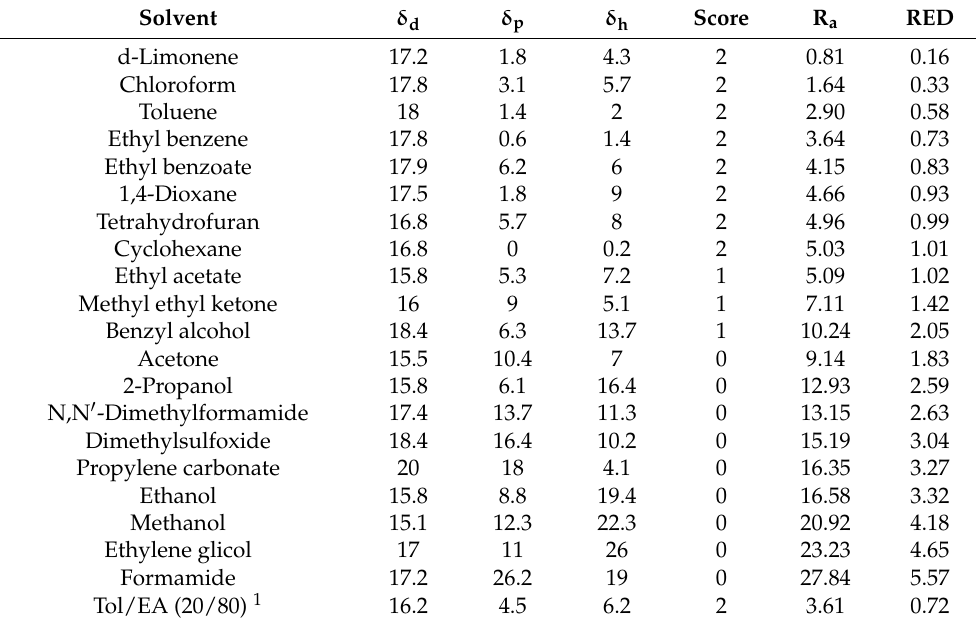
Table 3. HSPs, scores, and Ra and RED numbers of the solvents used for the dissolution of